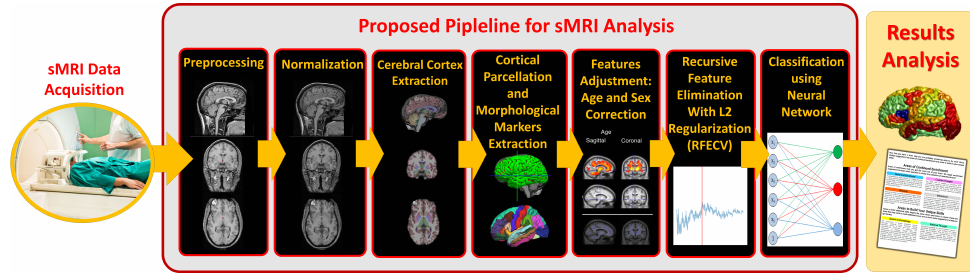
Figure 1. Overview of the proposed system starting from acquiring MRI volumes up to the